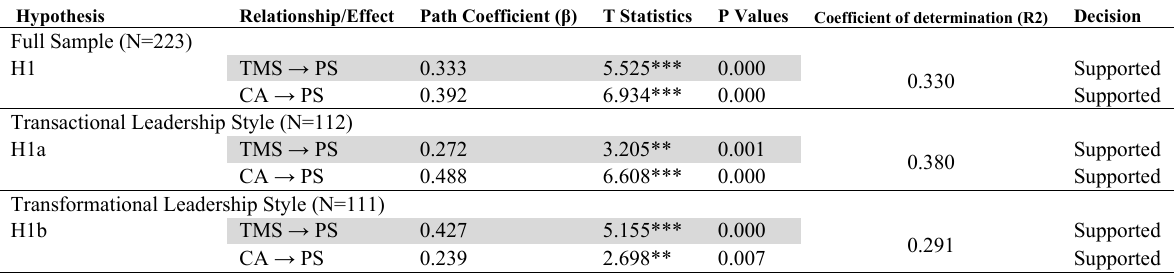
Results of structural model analysis for full sample and re-sampling Hypothesis